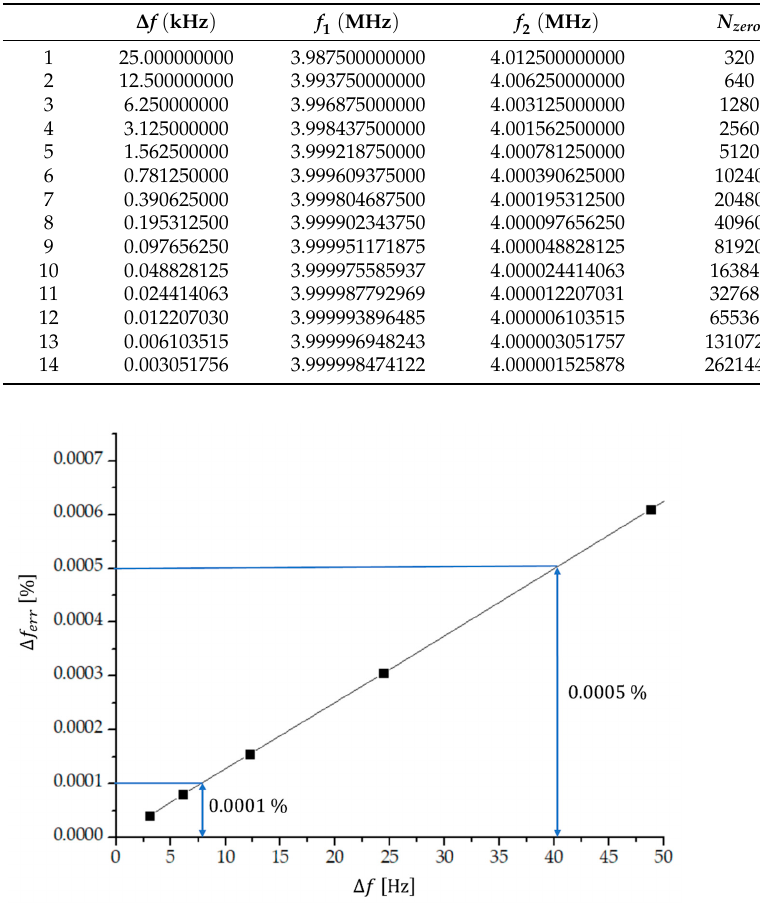
Figure 8. The relative experimental error of the measured frequency difference as a function of the frequency difference Δ𝑓 being lower than 50 Hz. See also Table 1. frequency difference ∆ f being lower than 50 Hz. See also Table